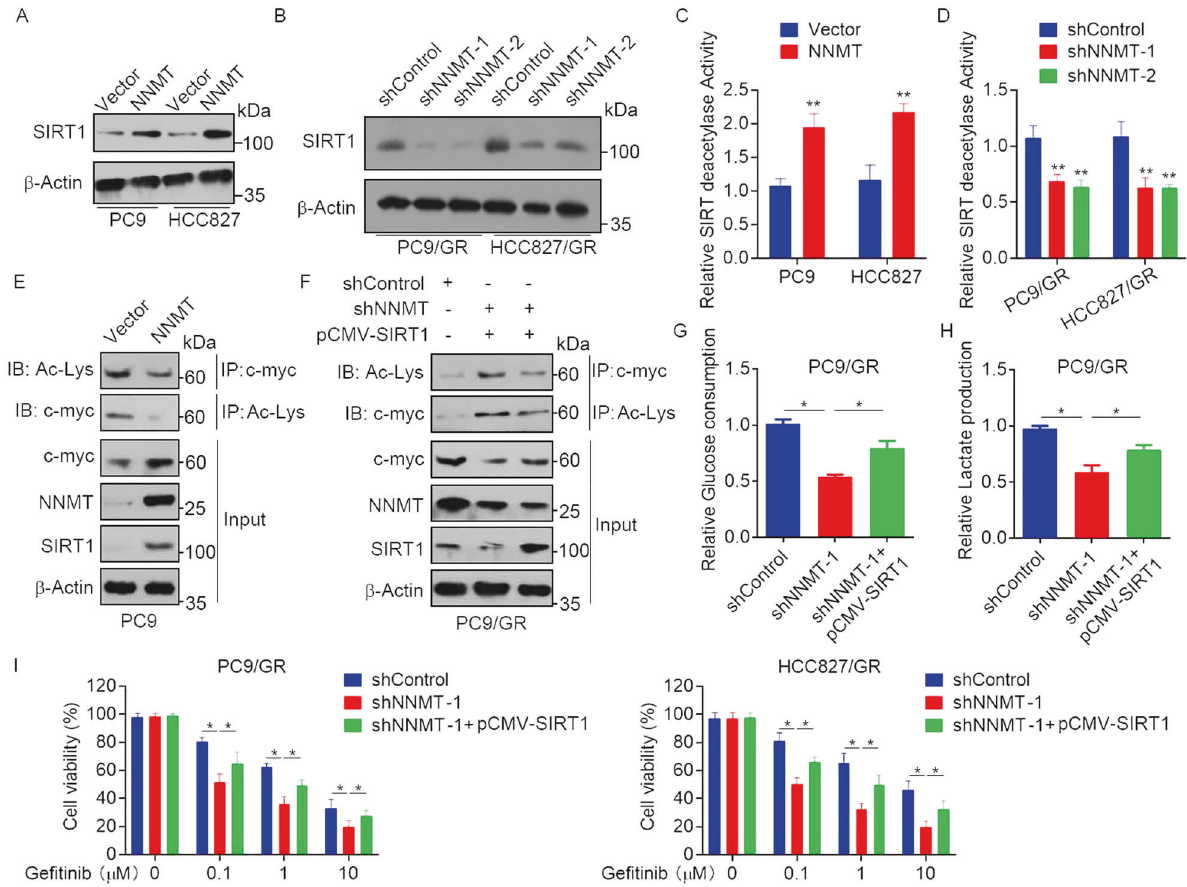
Fig. 5 NNMT promotes glycolysis and EGFR-TKIs resistance via SIRT1-mediated c-myc deacetylation. A , B PC9 and HCC827 cells were stably transfected with NNMT-overexpressing vector ( A ), PC9/GR or HCC827/GR cells were transfected with NNMT shRNA or control shRNA ( B ), the expression of STAT1 and β -actin were measured by Western blot. C , D PC9 and HCC827 cells were stably transfected with NNMT- overexpressing vector ( C ), PC9/GR or HCC827/GR cells were transfected with NNMT shRNA or control shRNA ( D ), the SIRT1 activity levels were determined using a SIRT1 deacetylase fl uorometric reagent kit. E Total protein extracts of PC9/GR cells that stably express NNMT or a control vector were subjected to IP using c-myc antibodies, followed by IB with Acetylated-Lysine Antibody and c-myc antibody. Reciprocal IP was done using Acetylated-Lysine Antibody, followed by IB with the c-myc antibody. F PC9/GR cells were co-transfected with NNMT shRNA or control shRNA and pCMV-SIRT1, the protein extracts were subjected to IP using c-myc antibodies, followed by IB with Acetylated-Lysine Antibody and c-myc antibody. Reciprocal IP was done using Acetylated-Lysine Antibody, followed by IB with the c-myc antibody. G , H Glucose uptake and Lactate secretion levels in PC9/GR cells co-transfected with NNMT shRNA or control shRNA and pCMV-SIRT1. I PC9/GR and HCC827/GR cells co-transfected with NNMT shRNA or control shRNA and pCMV-SIRT1 were treated with ge fi tinib at the indicated concentration for 72 h, cell viability was evaluated by MTS assay. Each point represents the mean ± SD. Data show a representative of three independent experiments. (* p < 0.05, ** p <